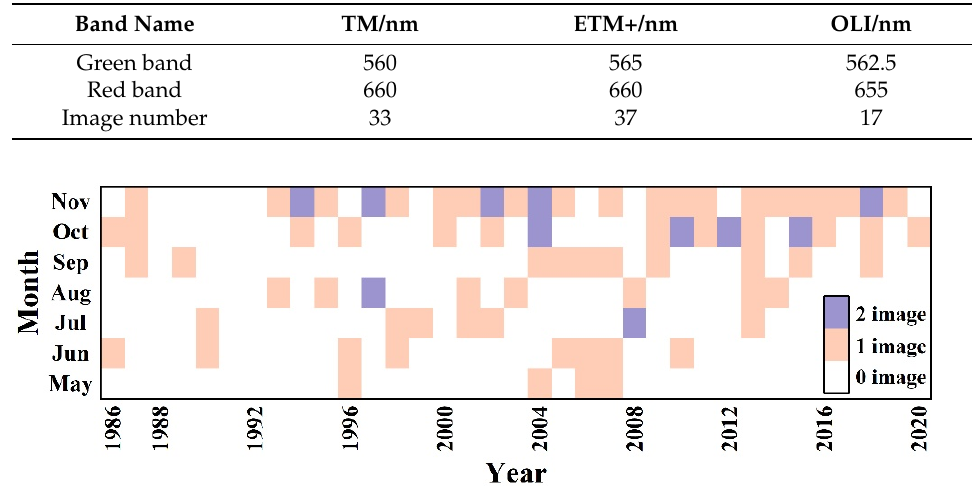
Table 1. The band center of Landsat sensors used in this paper, including thematic mapper (TM), enhanced thematic mapper (ETM+), and operational land imager (OLI).